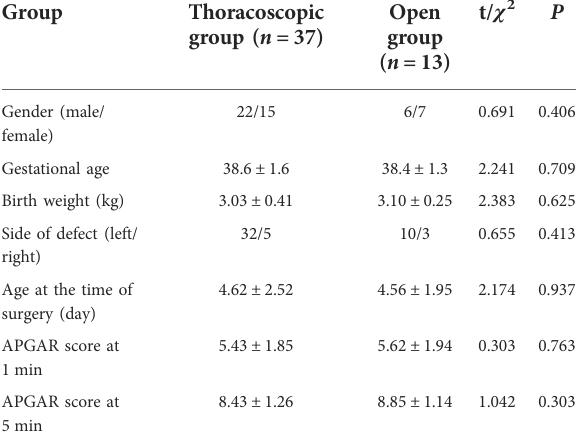
TABLE 3 Comparison of surgical complications.